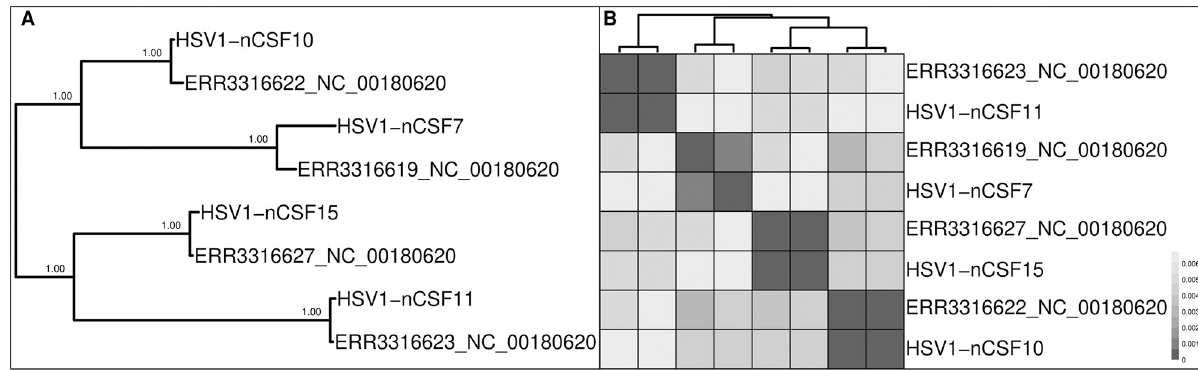
Fig 10. (A) Phylogenetic tree reconstructed for the HSV-1 dataset and (B) heatmap showing the pairwise distances of genome consensus sequences. Sample names starting with "HSV-1" represent the sequences reconstructed by Lassalle et al. (2020) [49], and accession numbers show the placement of the newly reconstructed genome sequences of the same samples. The accession of the reference genome used for the analysis is given next to the accession number of raw read data.